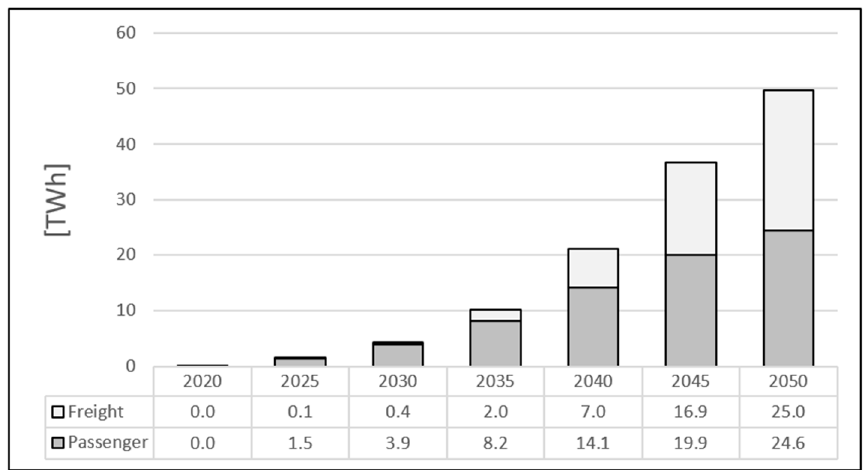
Figure 13. Electricity demand in passenger transport (electric cars and buses) and in freight transport (LDV’s, HDV’s) [NEU scenario] [TWh]. Source: own calculations based on TR 3 E model results.